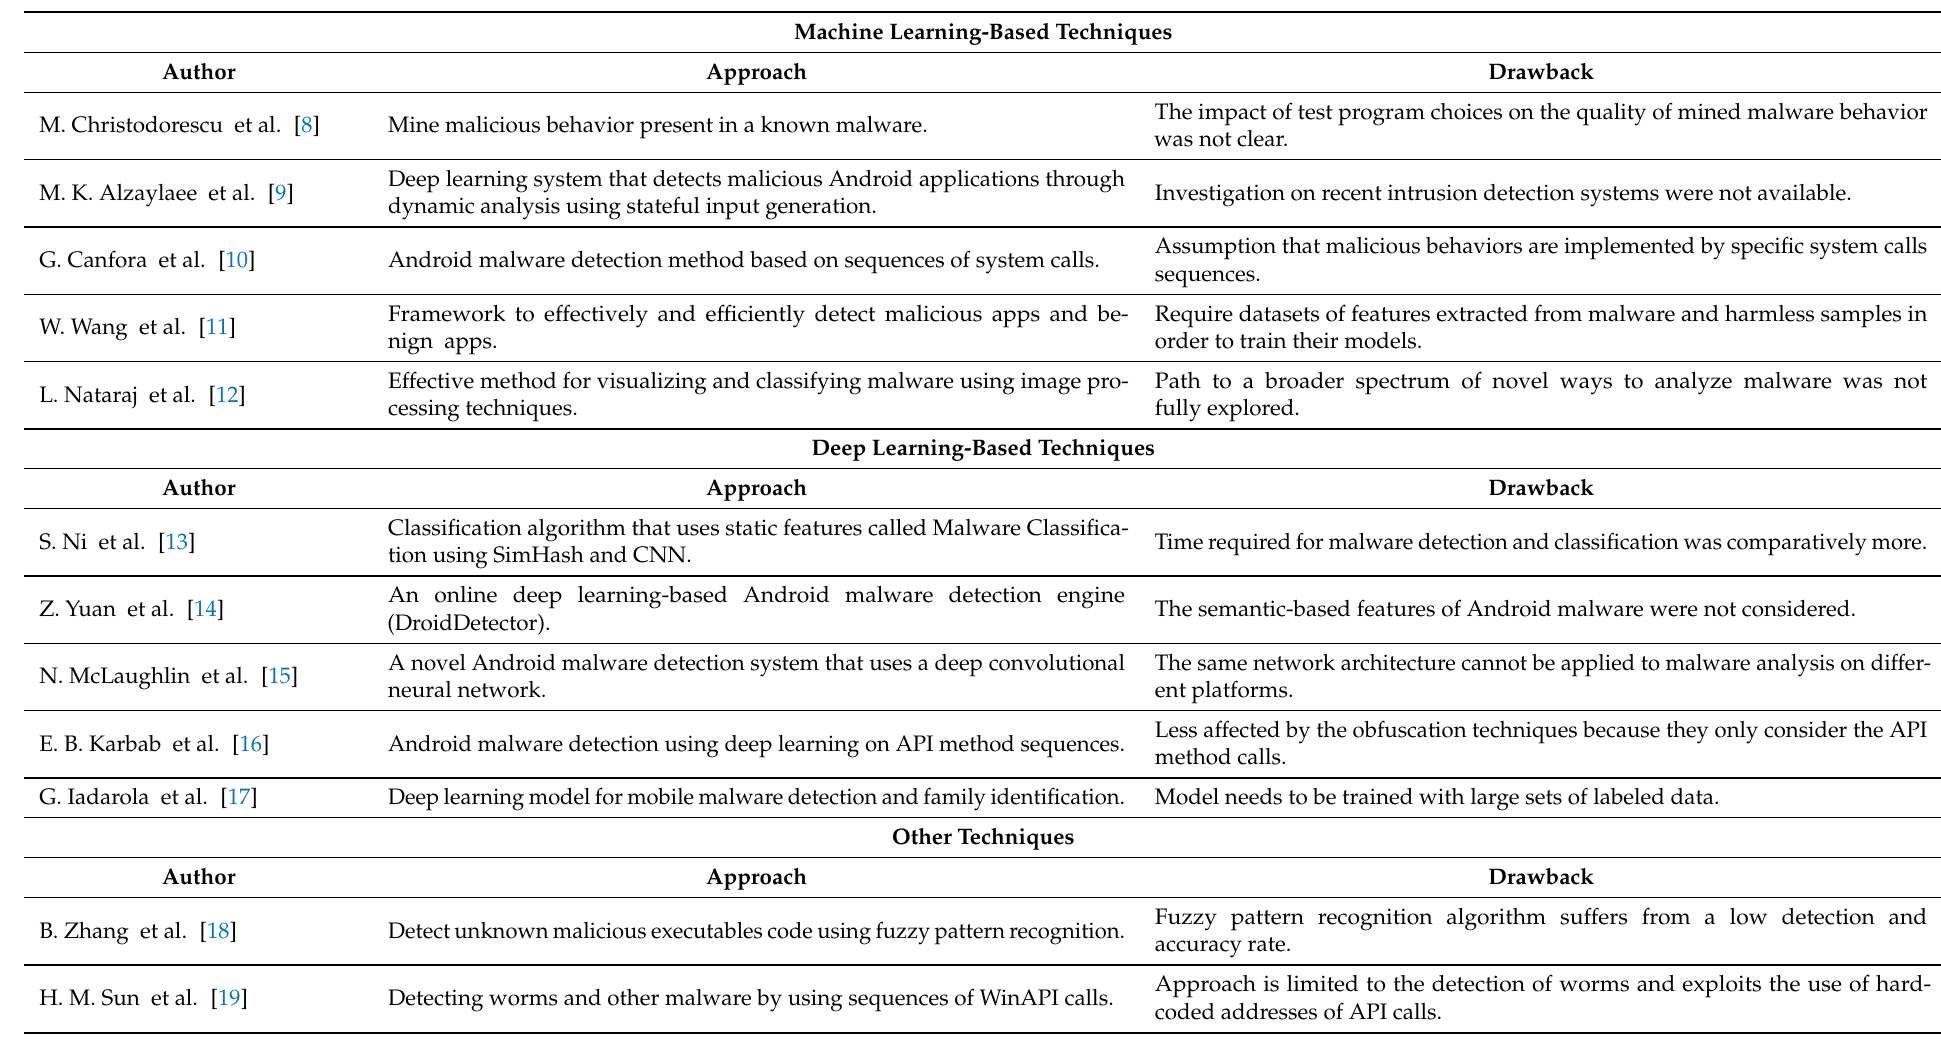
Table 1. Comparison of existing